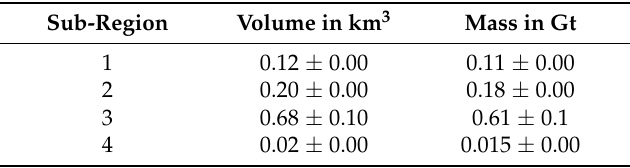
Table 4. Glacier volume and mass in the sub-regions.